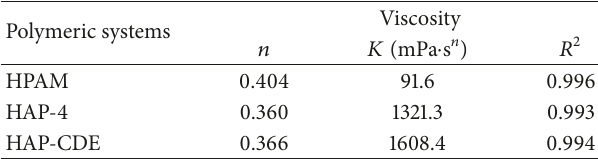
Table 2: Rheological property of the three polymeric